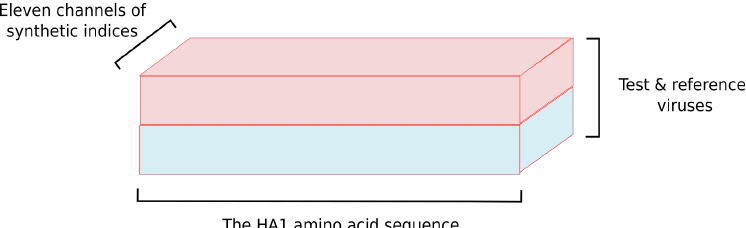
Figure 5. The network input tensor represents the HA1 amino acid sequence of test and reference viruses encoded by 11 synthetic indices from